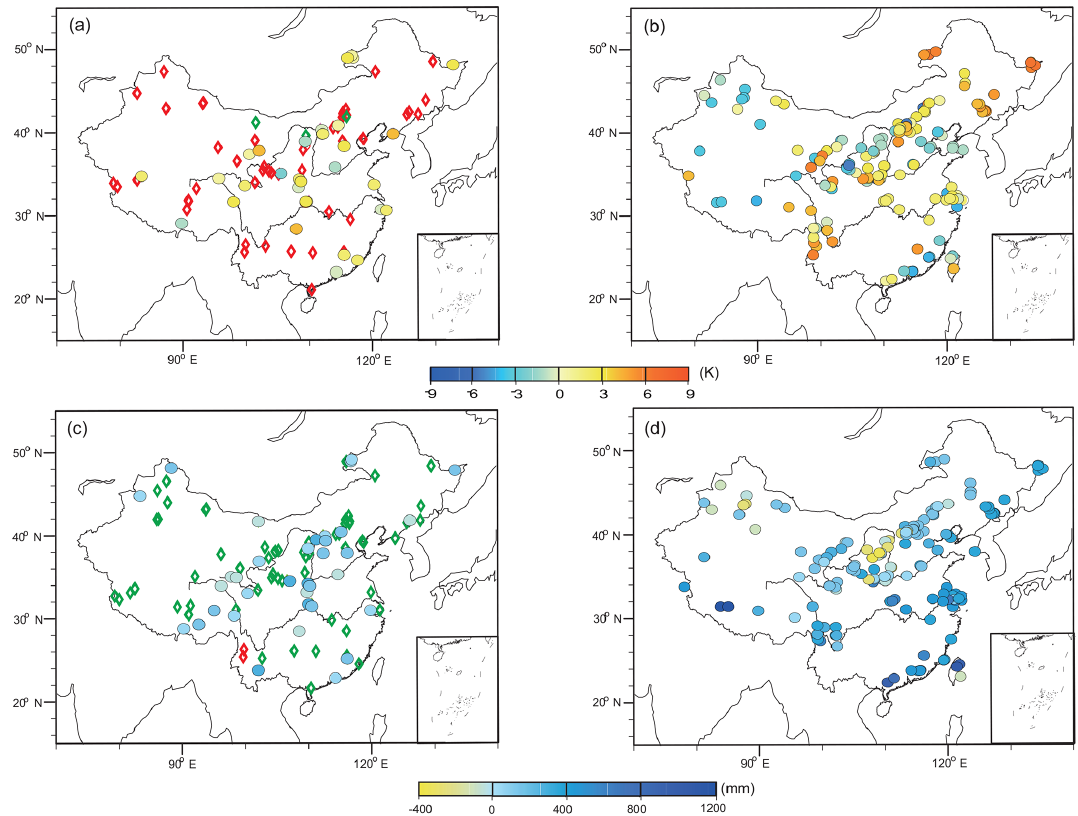
Figure 7. Comparison between the climate reconstruction and previous reconstruction over China. (a) Previous temperature results. The diamond is the qualitative reconstruction, red is the temperature increase and green is the temperature decrease; the circle is the quantitative reconstruction. (b) Mean annual temperature reconstruction in this study; (c) previous precipitation results. The diamond is the qualitative reconstruction, red is the precipitation decrease and green is the precipitation increase; the circle is the quantitative reconstruction. (d) Mean annual precipitation reconstruction in this